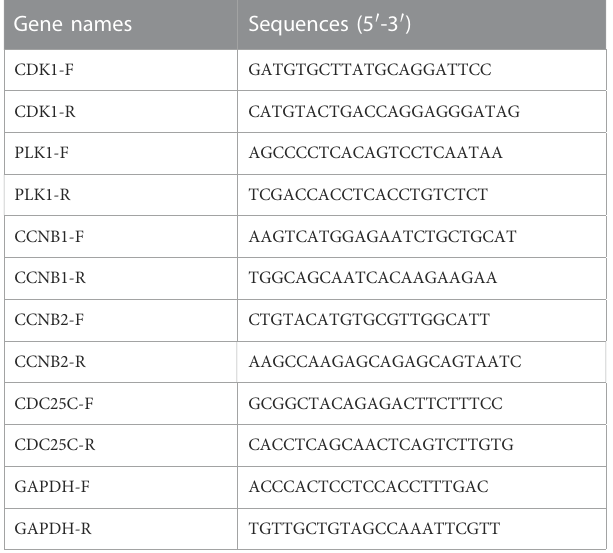
TABLE 1 Primers used for qPCR